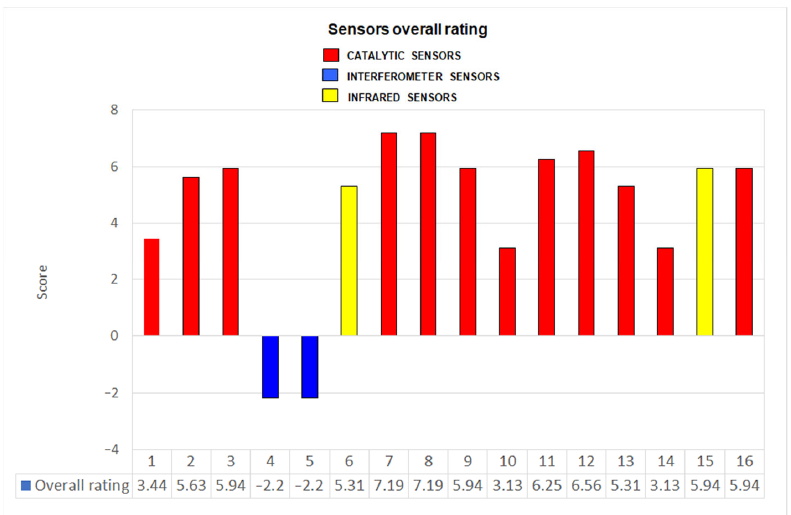
Figure 18. Overall rating for each sensor.